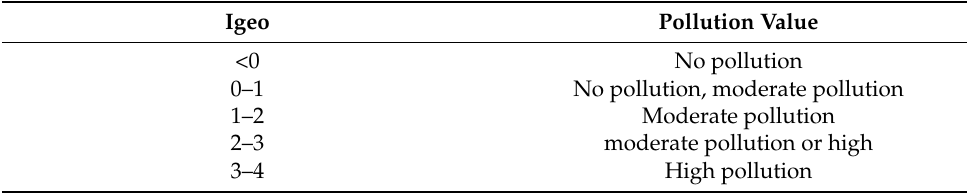
Table 3. Classification of Igeo